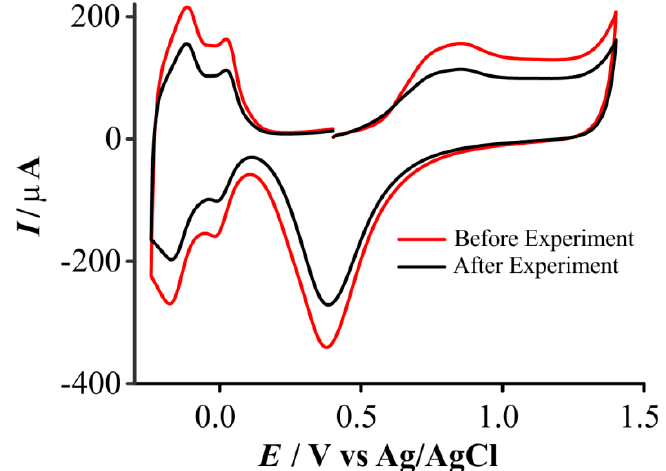
Figure 6. Comparison of cyclic voltammograms (10 th cycle, 500 mVs − 1 ) recorded before (red) and after (black) a gas sensing experiment in the room temperature ionic liquid (RTIL) on a 3D nanostructure decorated MATFE (300 s Pt/Pb + 120 s Pt/Pb) in N 2 -saturated 0.5 M H 2 SO 4(aq) .